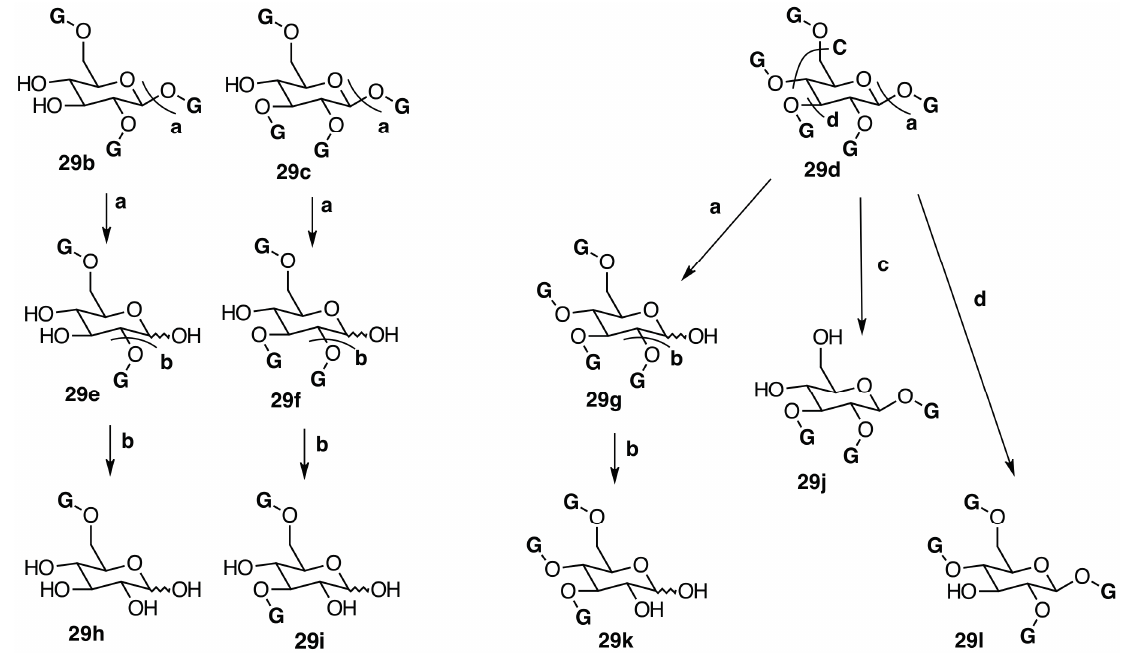
Figure 8. Degalloylation ( a , b , c , d ) of galloyl